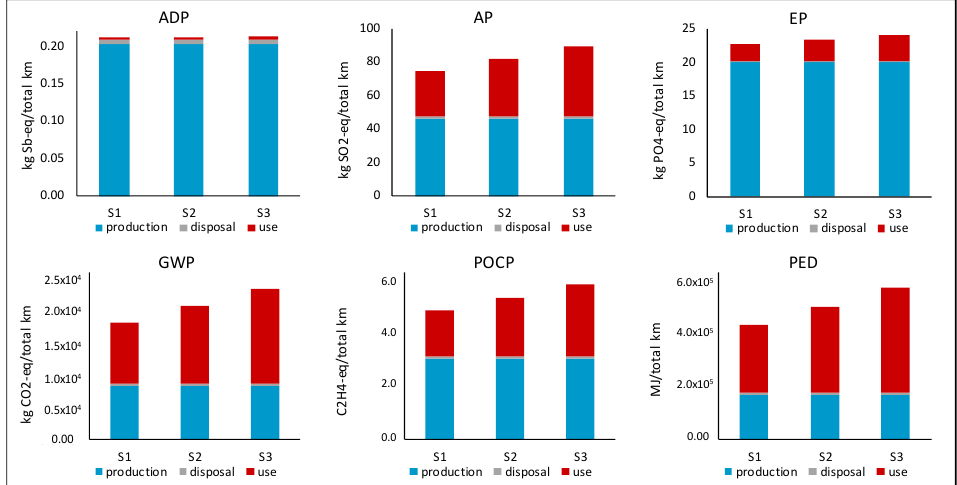
Figure 7. Impact per total kilometers achieved for each scenario defined in Table 6 with a breakdown of the contribution from production, disposal and use phases of the life